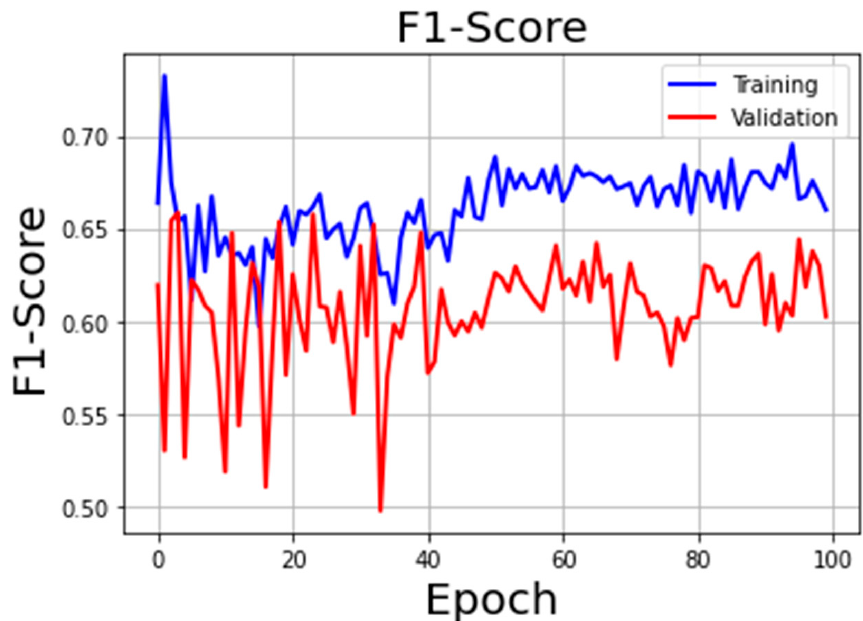
Figure 6. Focal Loss curve during training and validation.